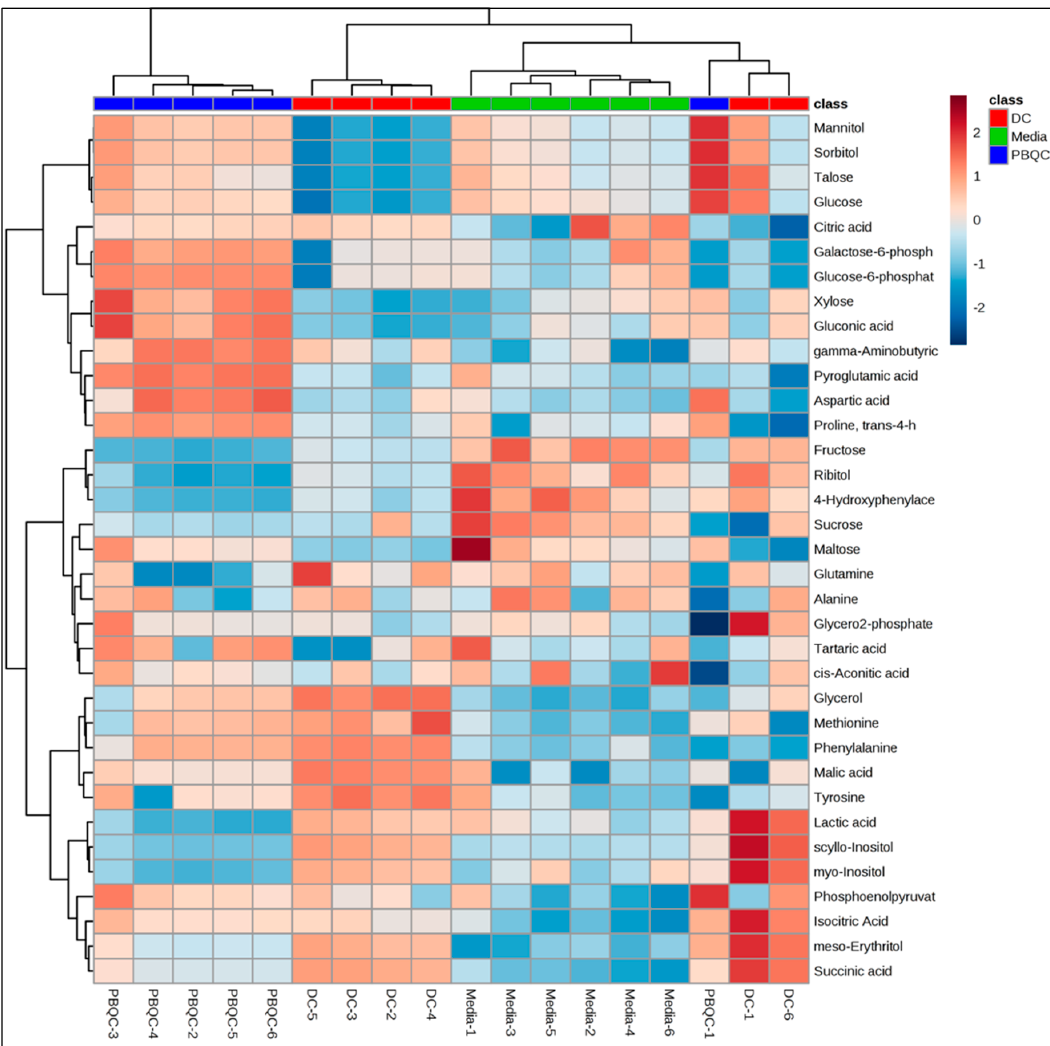
Figure 3. Heat map showing polar metabolites of D. caninum ESP. Heat map was generated using MetaboAnalyst 4 ( N = 6 replicates). Deep brown denotes highest peak areas of metabolites and deep blue denotes lowest peak areas or complete absence of metabolites.